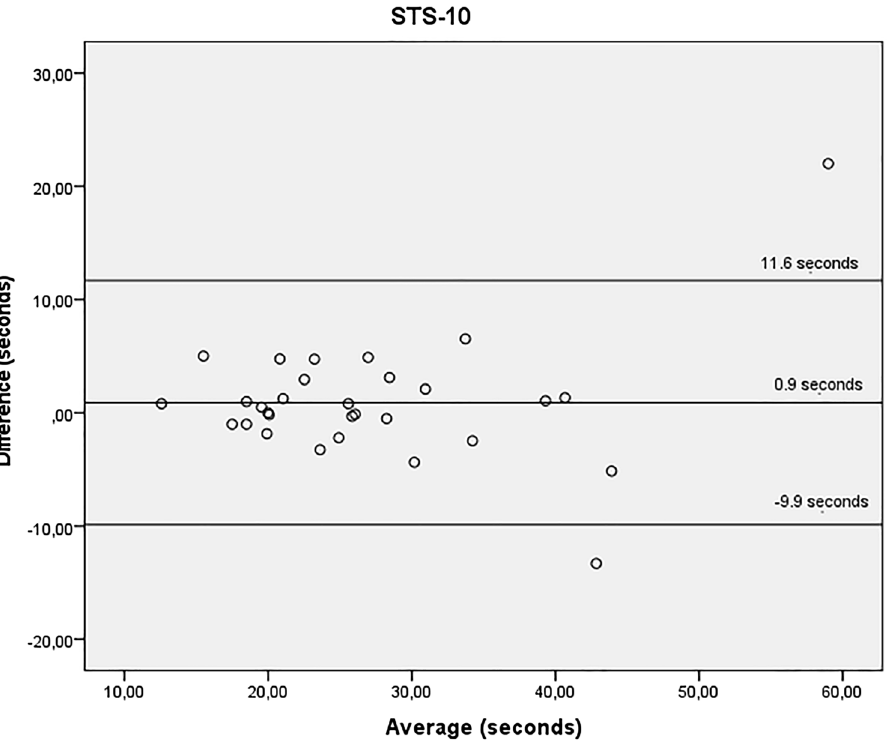
Figure 1. Bland–Altman plots showing agreement for the time required to perform the sit-to-stand-to-sit 10 test, obtained before the haemodialysis session and on a non-dialysis day by the same rater. Y axis difference between (non-dialysis—before the haemodialysis session) in seconds. X axis average (non-dialysis + before the haemodialysis session)/2